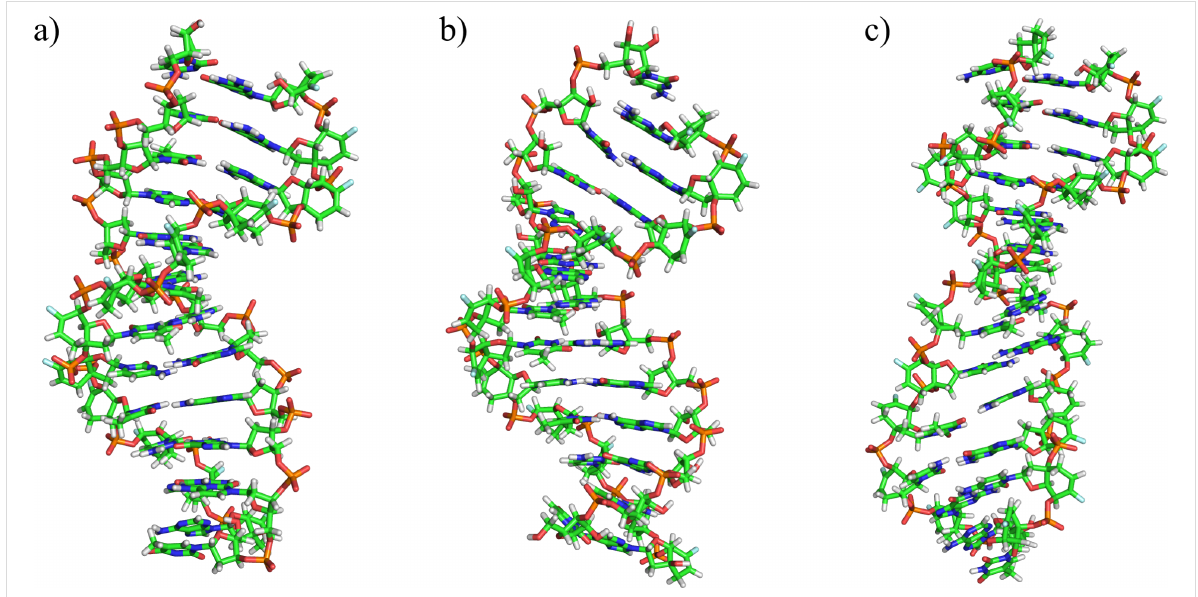
Figure 4: Average structures of the a) 6’F-bc 4,3 -DNA/DNA, b) 6’F-bc 4,3 -DNA/RNA, and c) 6’F-bc 4,3 -DNA/6’F-bc 4,3 -DNA duplexes obtained from the last nanosecond of the simulation by firstly extracting a frame each 50 ps and secondly by doing an averaging of them.